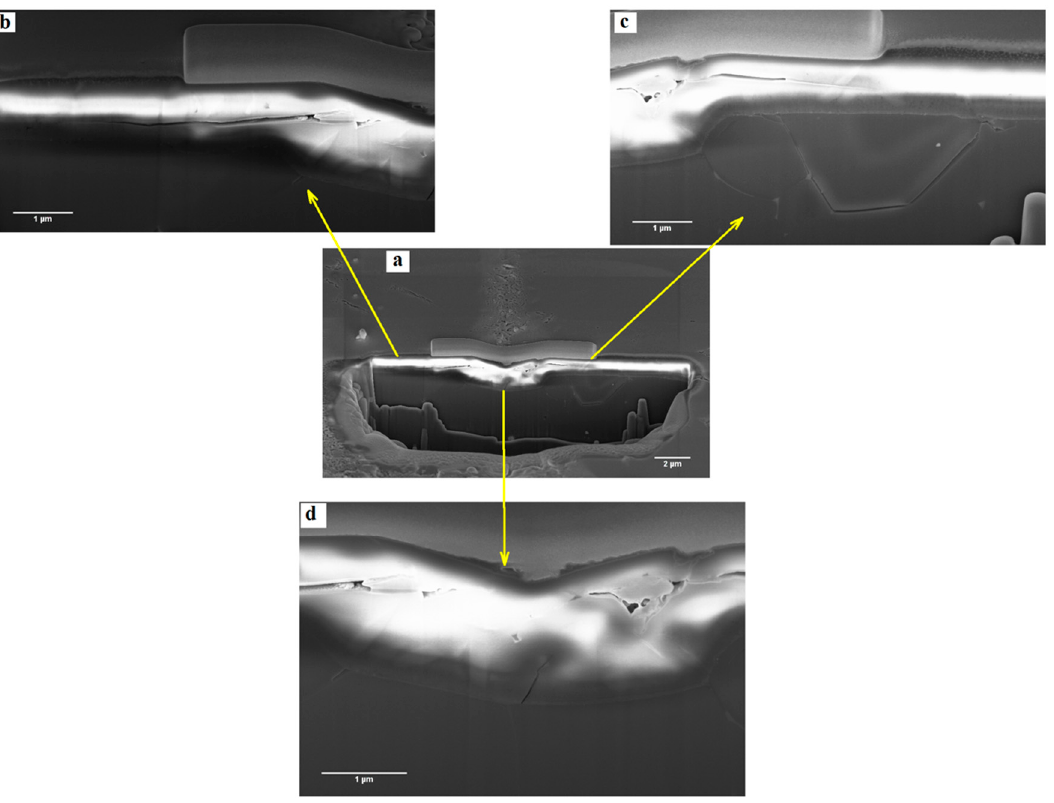
Figure 5. FIB cross section of zone 1 (refer to Figure 4b). General ( a ), lateral ( b , c ), and central ( d ) details of the cross section.